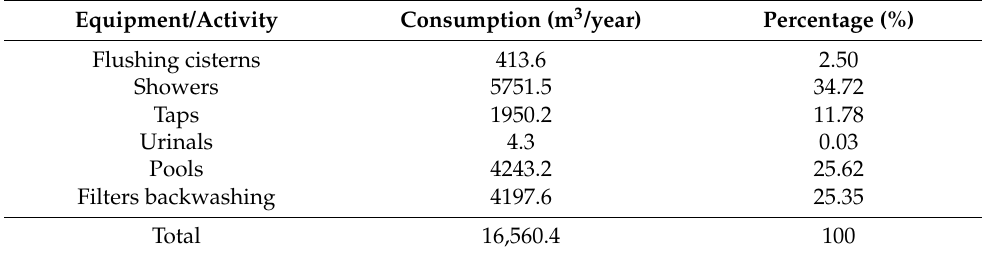
Table 3. Average annual water consumption in swimming pools by use